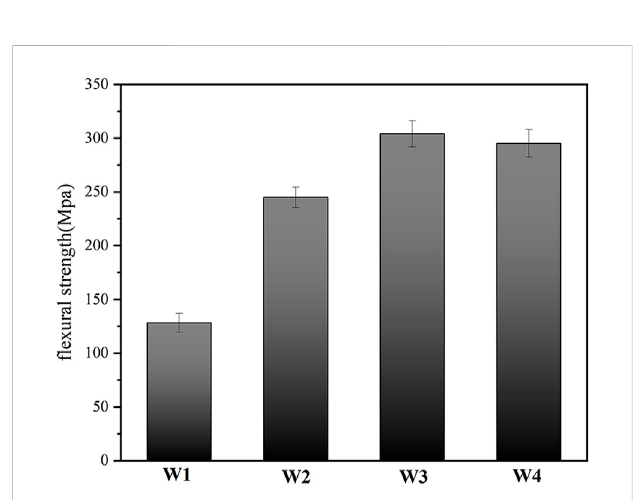
FIGURE 7 Flexural strength of LD glass-ceramics treated by different temperature.